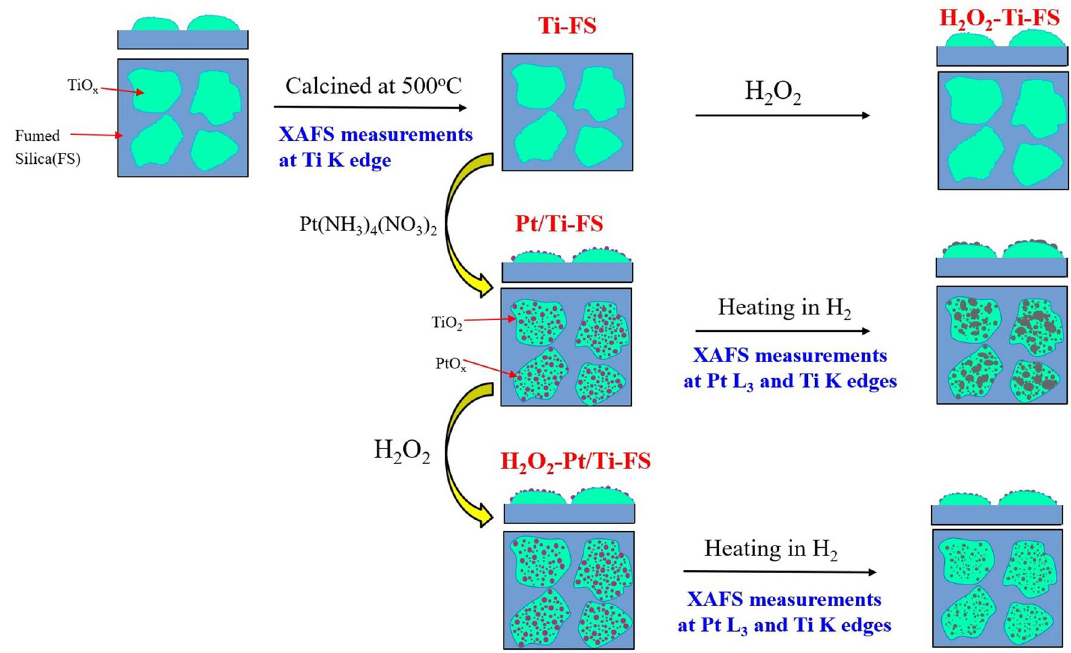
Figure 1. Synthesis procedure of Pt/Ti–FS, specimen names, and conditions of XAFS